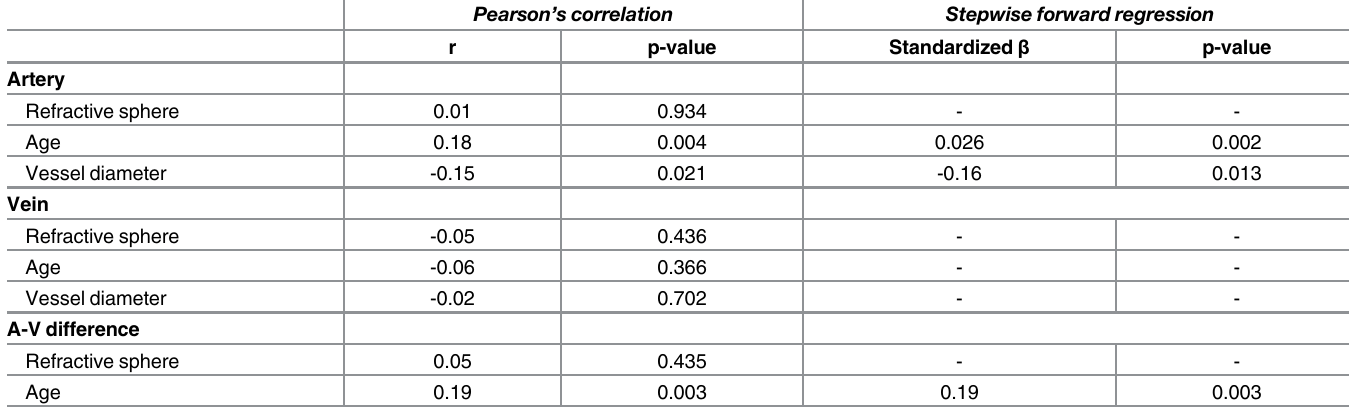
Table 6. Correlation between Refractive Sphere, Age, or Vessel Diameter, and Oxygen Saturation in the Major Retinal Vessels. Pearson ’ s